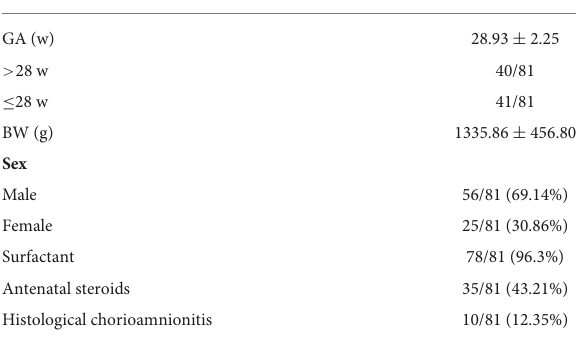
TABLE 1 Clinical data of 81 BPD